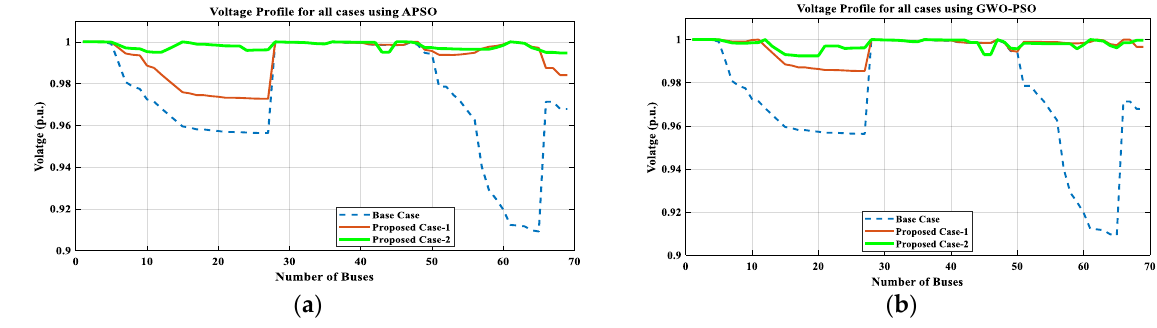
Figure 20. Voltage profile of 69-bus RDN for all cases; ( a ) APSO, ( b ) GWO.